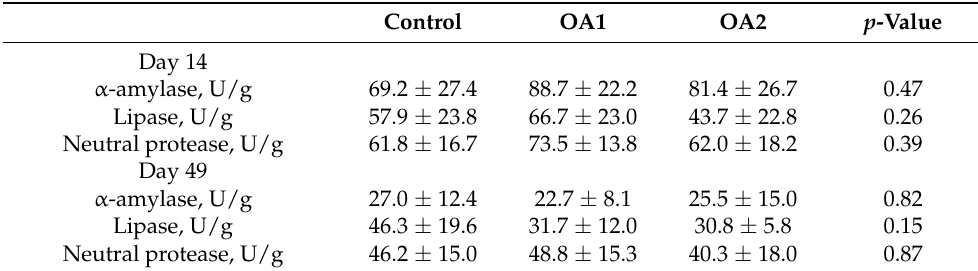
Table 3. Effects of organic acids on the digestive enzyme activity of jejunum chime 1 .